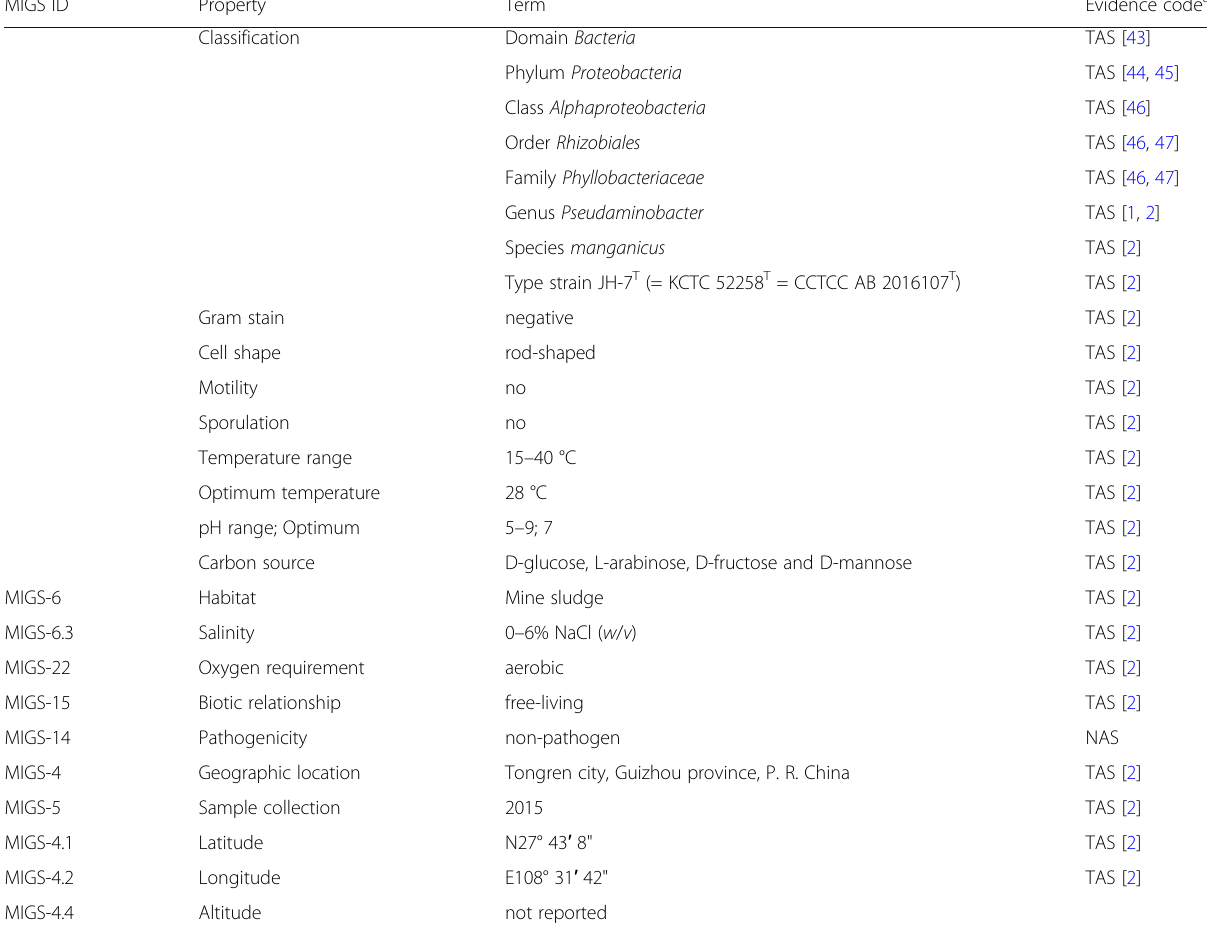
Table 1 Classification and general features of P. manganicus JH-7 T